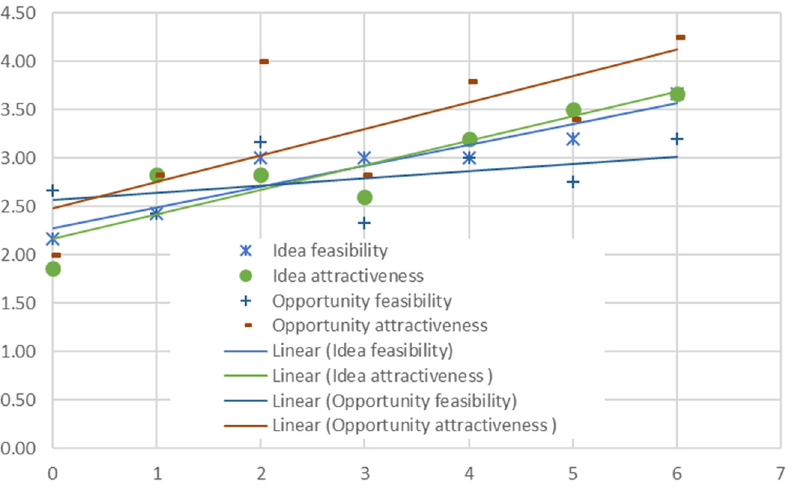
Figure 2. Trends of mean values of business idea and opportunity assessments by seven students on Likert scale 1–5. Checkpoints 0–6 correspond to Table 1.